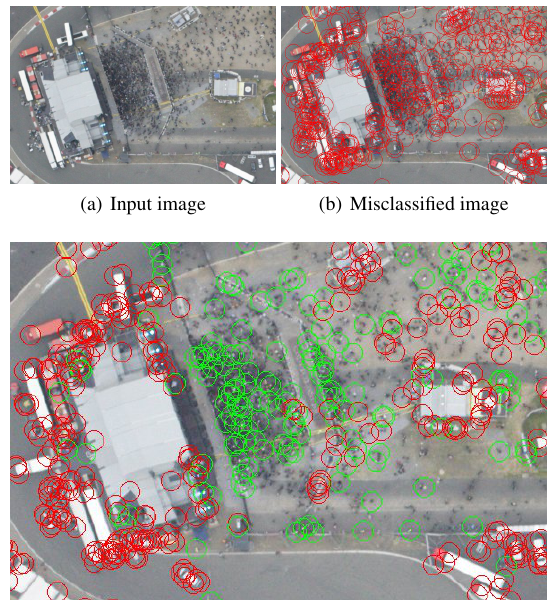
Figure 6: Figures b and c have a low RMSE when compared to the reference image. However, while Figure b also has a low RMSE it has a high D KL which helps us to understand the totally misclassified image. The result in Figure c is considerably better where both RMSE and D KL are low.